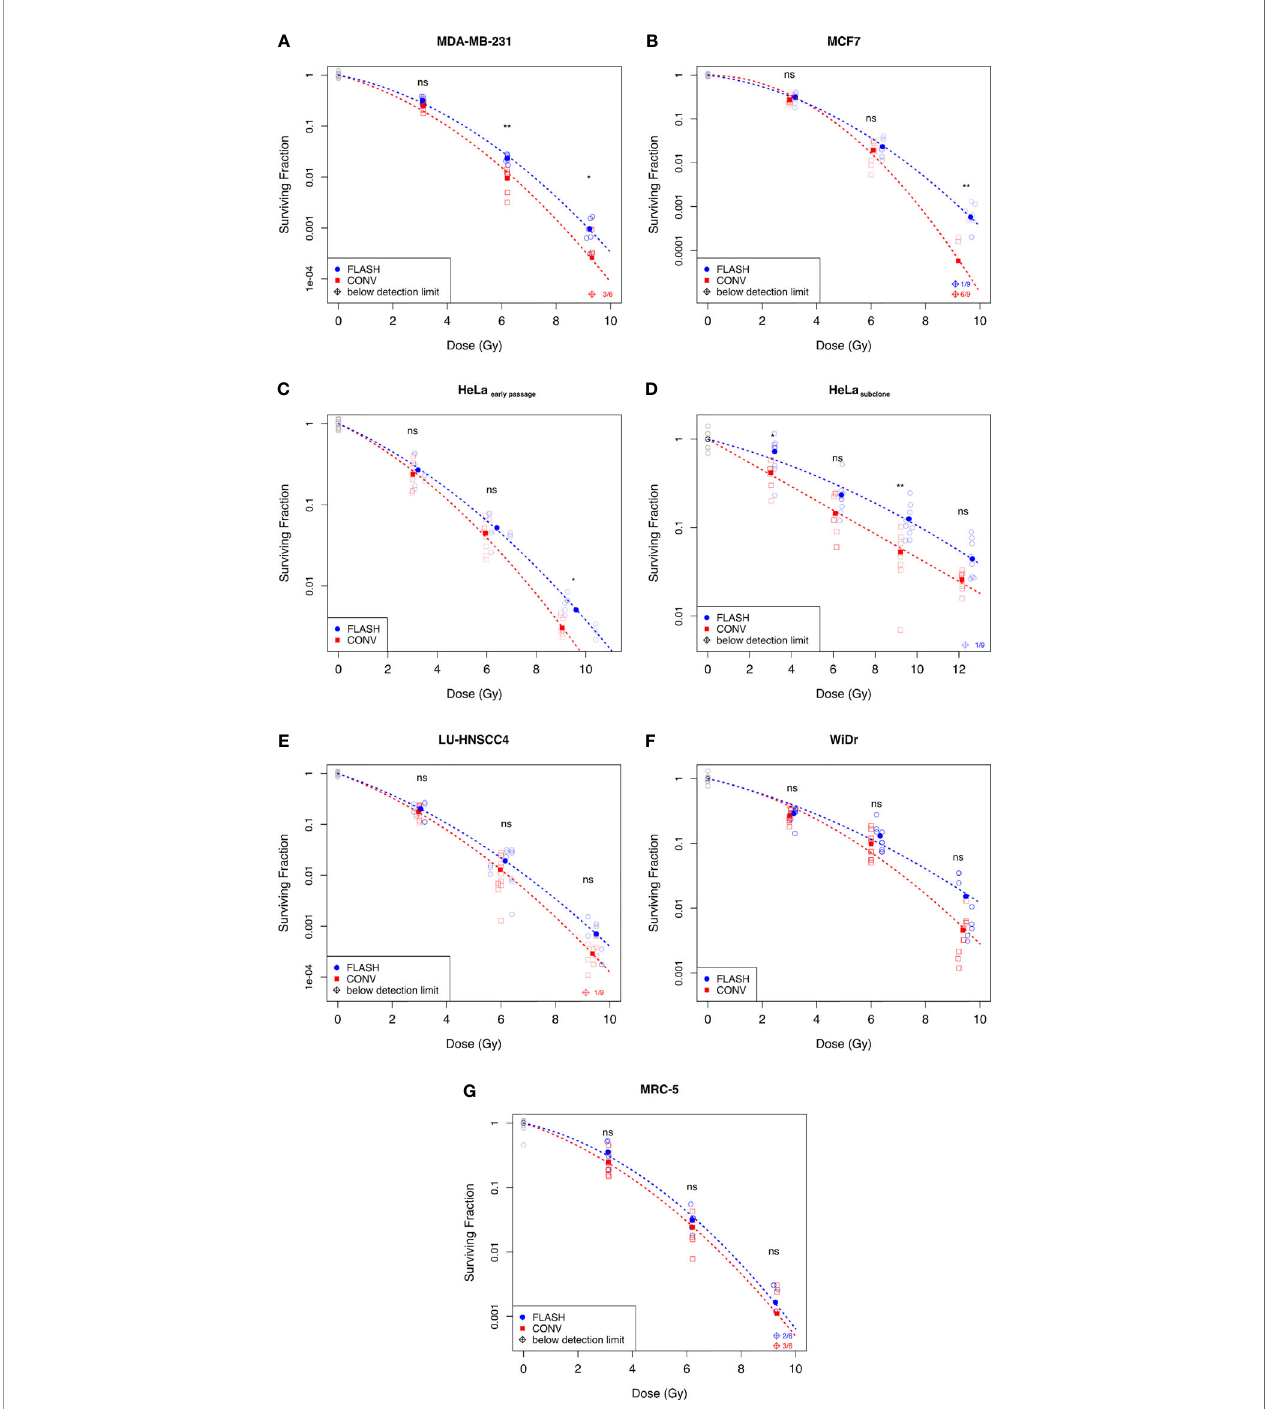
FIGURE 1 | Surviving fraction assessed by clonogenic assay comparing FLASH with conventional dose rates (CONV) for human in vitro- cell lines; (A) Breast cancer cell line MDA-MB-231, (B) Breast cancer cell line MCF7, (C) Cervix cancer cell line HeLa early passage , (D) HeLa subclone (E) Head&neck cancer cell line LU-HNSCC4, (F) Colon cancer cell line WiDr, and (G) Normal lung fi broblasts MRC-5. Blue circles denote FLASH, red squares denote CONV, and grey circles denote the non- irradiated controls. The empty symbols represent the individual fl asks and the fi lled symbols represent the average surviving fraction at the dose indicated. The dashed lines illustrate the fi tted survival curve according to the linear quadratic model. Diamond symbols denote samples below the detection limit (no surviving colonies). Statistical analyses using Wilcoxon Rank-Sum test; ns, not signi fi cant, *p < 0.05, **p < 0.01. Data from three independent